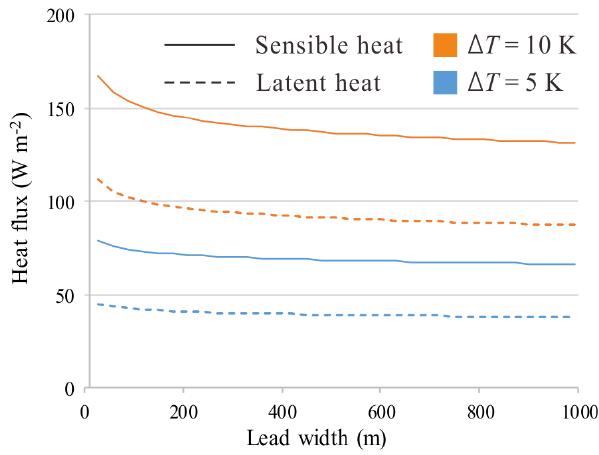
Figure 4. Turbulent heat flux for each width at wind speed of 5ms − 1 . Temperature difference between air and lead surface is marked by line color.